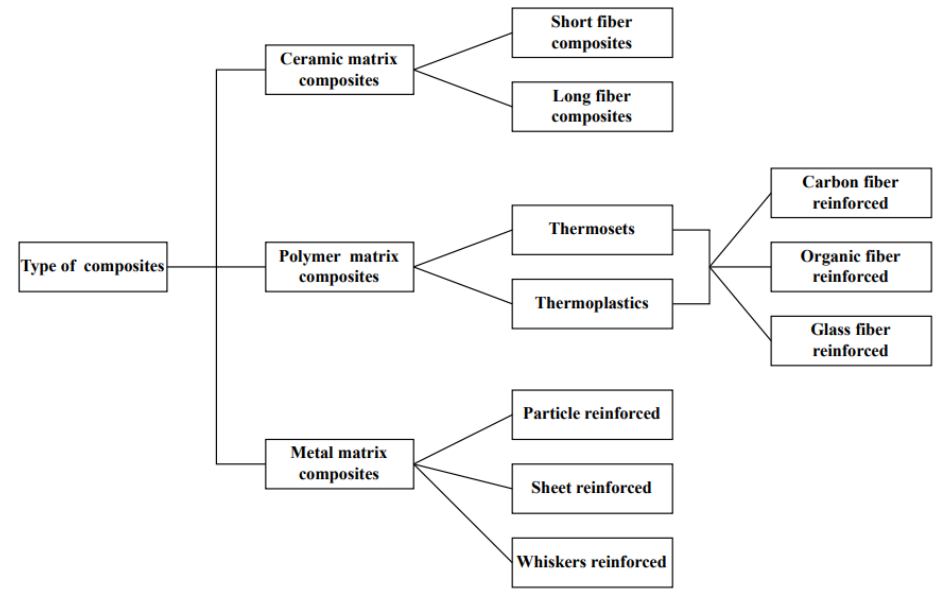
Figure 4. Classification of the type of matrix composites.